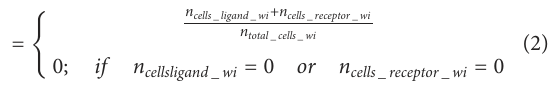
Algorithm 1: Cell detection by window